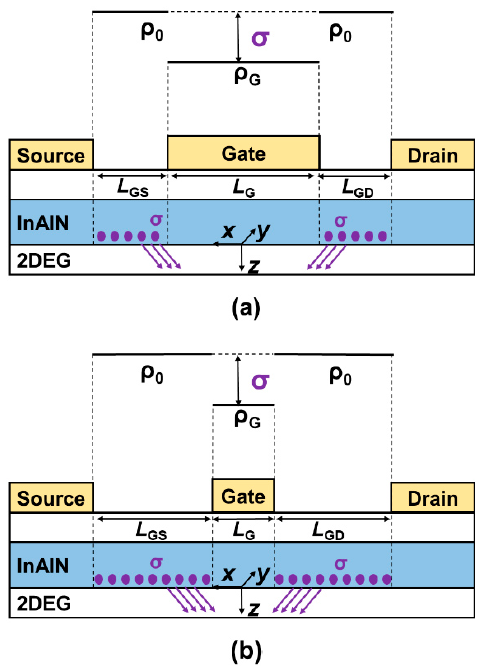
Figure 13. Schematic of the additional polarization charge ( σ ) distribution in InAlN barrier with ( a ) large and ( b ) small gate length L G . The source–drain spacing L SD is